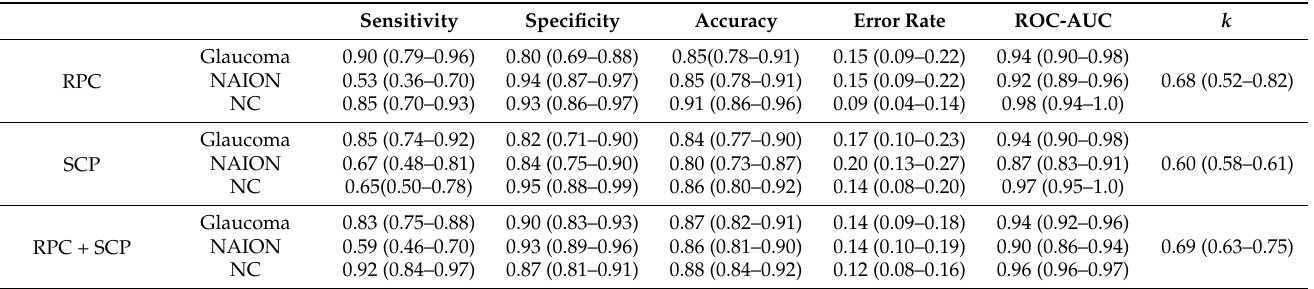
Table 2. Performance of the deep learning architecture for glaucoma, non-arteritic anterior ischemic optic neuropathy and normal control optical coherence tomography angiography (OCTA) classification.